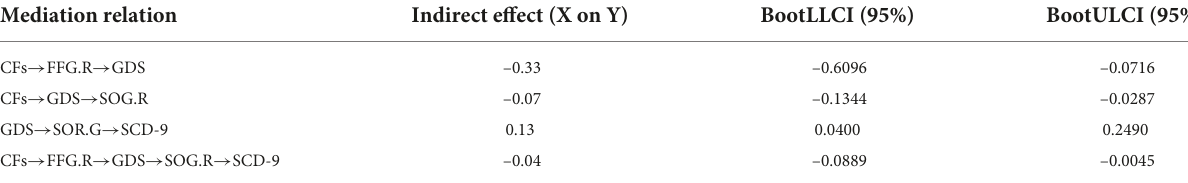
TABLE 2 The indirect effect value and 95% confidence interval of the mediation effect of the four